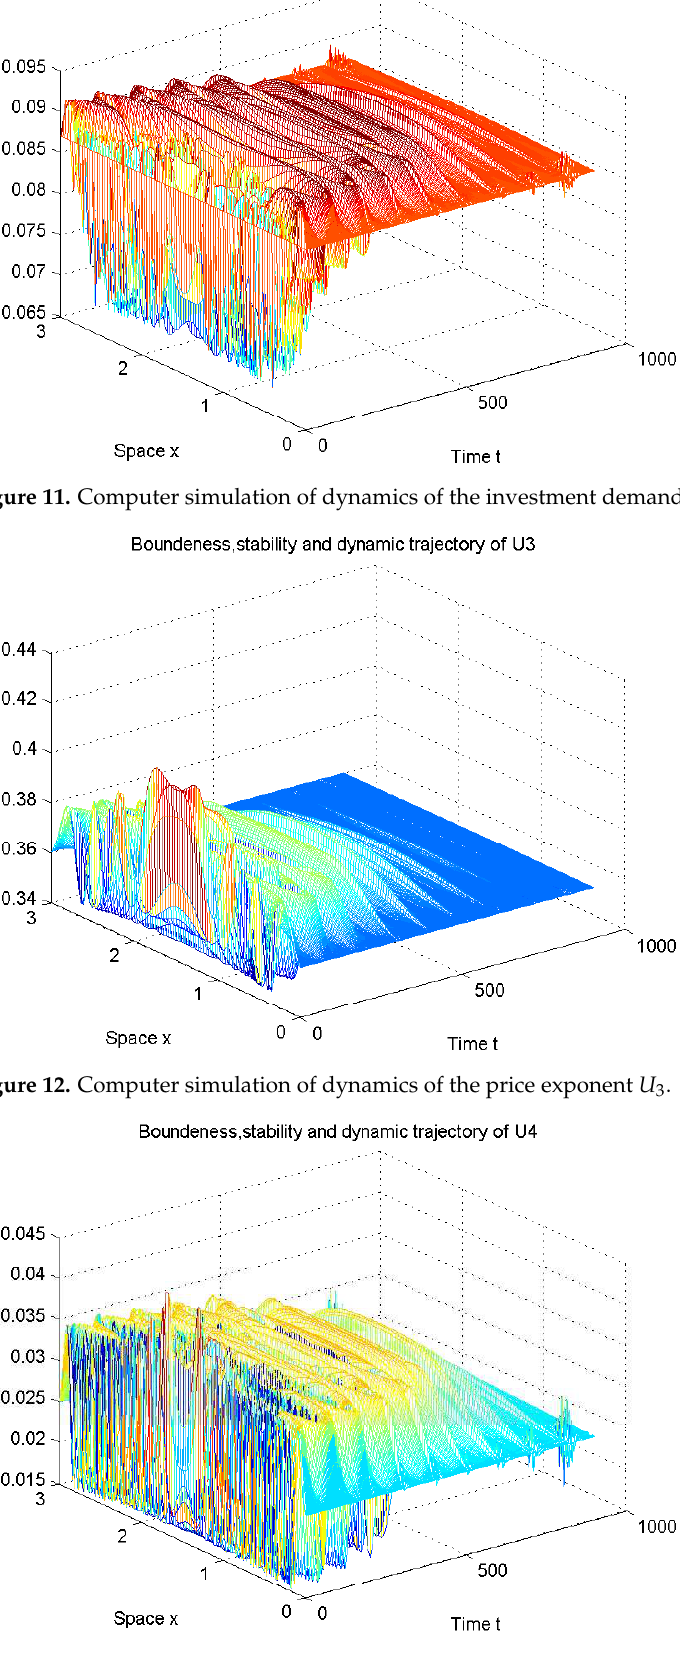
Figure 13. Computer simulation of dynamics of the average profit margin U 4